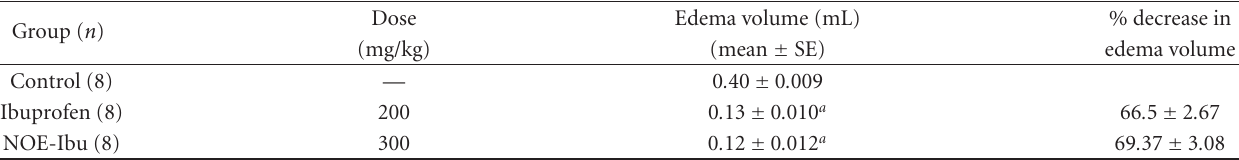
Table 4: E ff ect of ibuprofen and its NOE on carrageenin-induced rat paw edema (by Sche ff e’s test—SPSS computer package). ( n = number of animals.) The di ff erence between any two means is statistically significant if the mean di ff erence is more than the allowance value